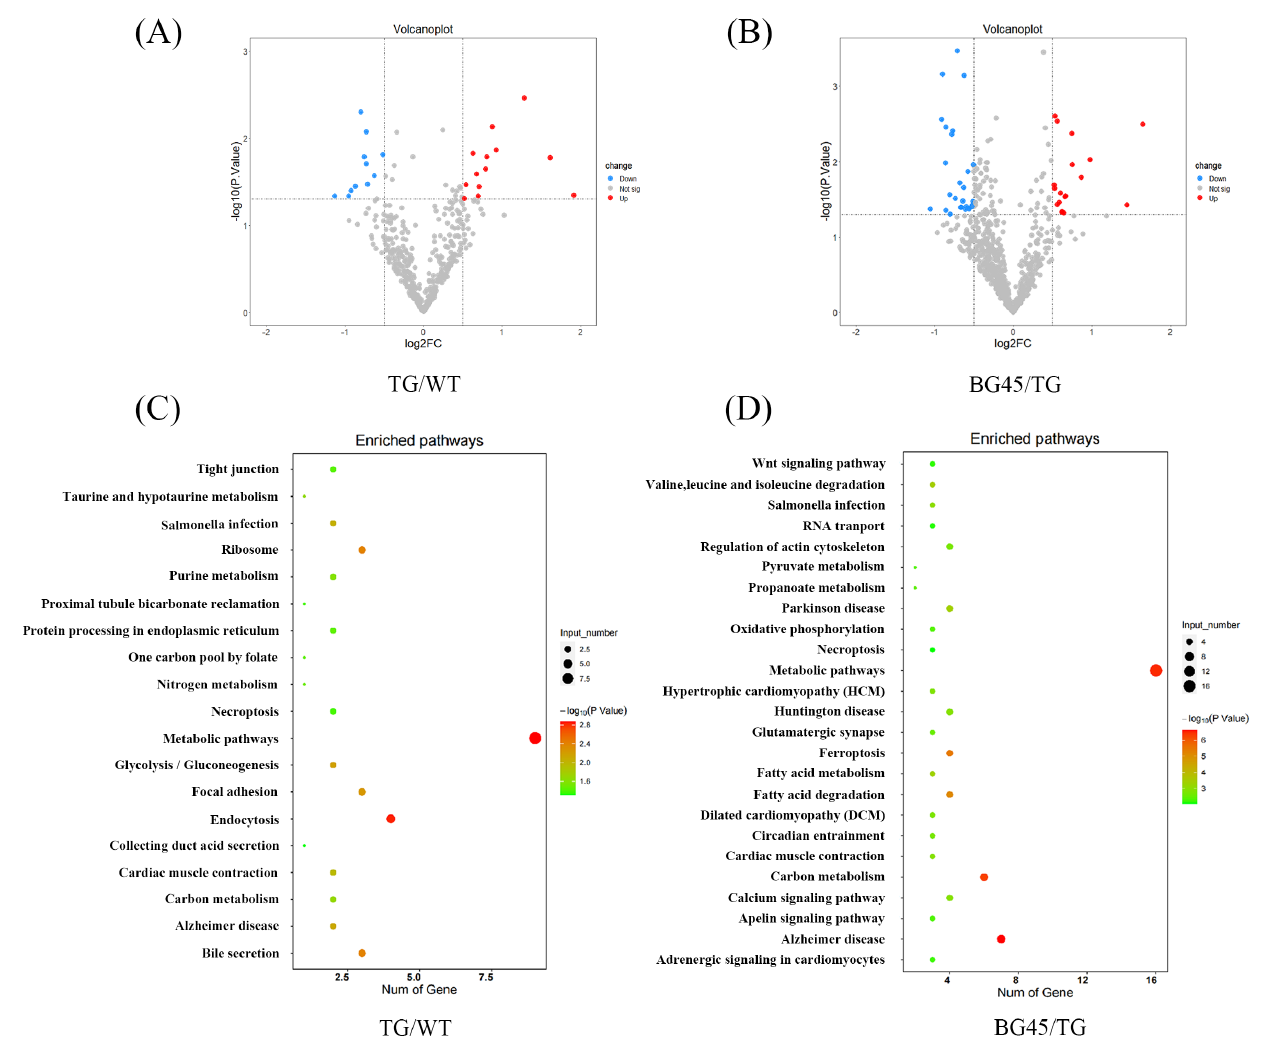
Figure 6. Differentially expressed proteins in the mouse prefrontal cortex and KEGG pathway analysis of differentially expressed proteins. ( A ) Volcano plot of differentially expressed proteins in the TG group vs. the WT group (red and blue points indicate up- or downregulated significant proteins, respectively). ( B ) Volcano plot of differentially expressed proteins in the BG45 group vs. the TG group (red and blue points indicate up- or downregulated significant proteins, respectively). ( C ) Pathway analysis of differentially expressed proteins in the TG group vs. the WT group. ( D ) Pathway analysis of differentially expressed proteins in the BG45 group vs. the TG group. P values are emphasized in color from the most extreme decrease (light green) to the highest increase (dark red).